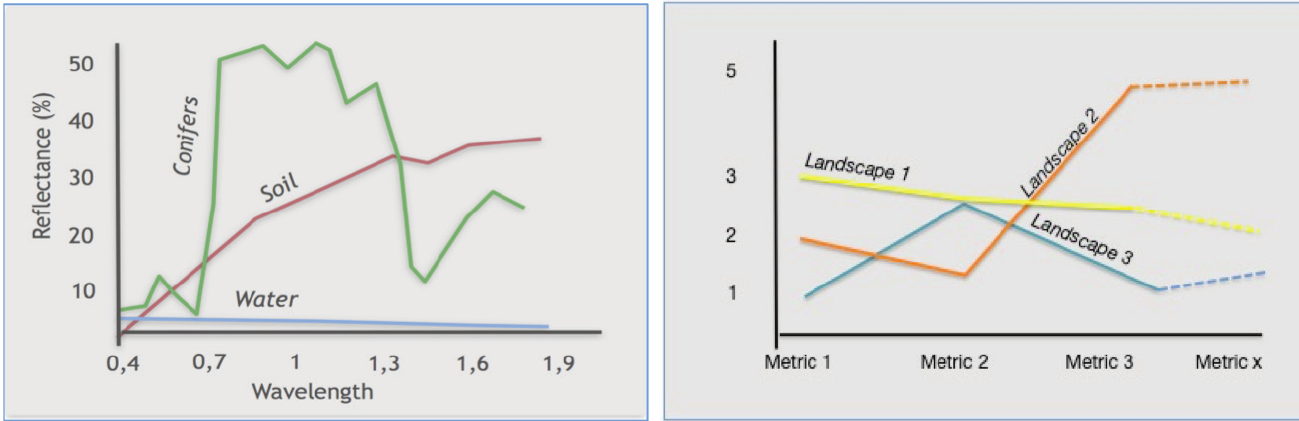
Figure 3: (a) Hypothetical example of a spectral signature (b) Hypothetical example of a “landscape